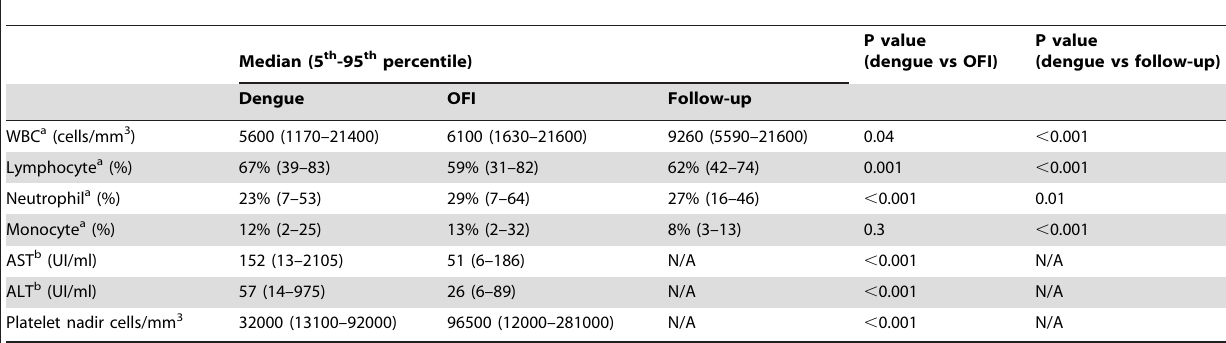
Table 3. Hematological findings in infants during hospitalization and at